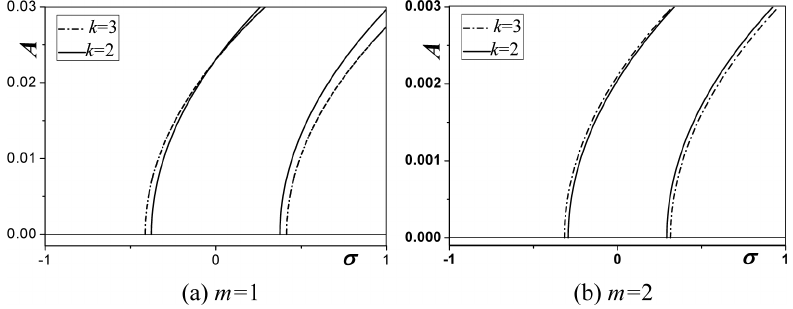
Fig. 5. Effects of the rotational spring stiffness: Eq.